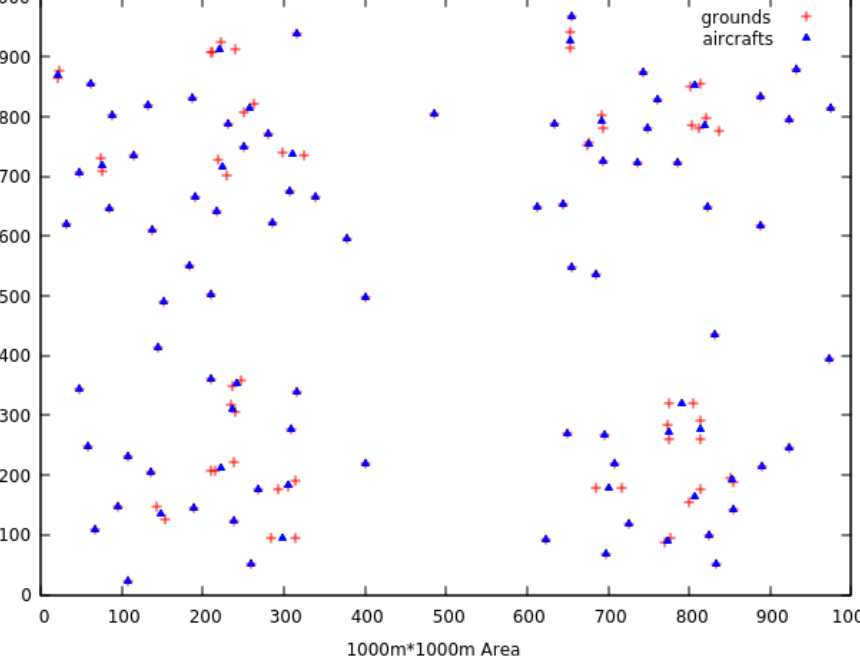
Figure 3. Set of aircraft placements obtained using reduced